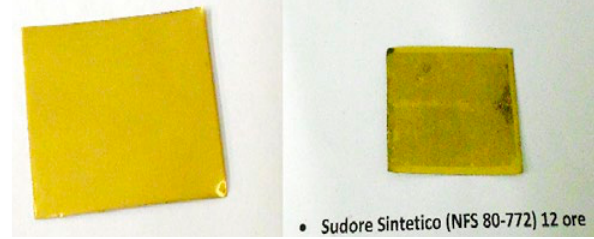
Figure 5. Corrosion test of a gold-plated sample, before (left) and after (right) 12 hours under syntenic sweat